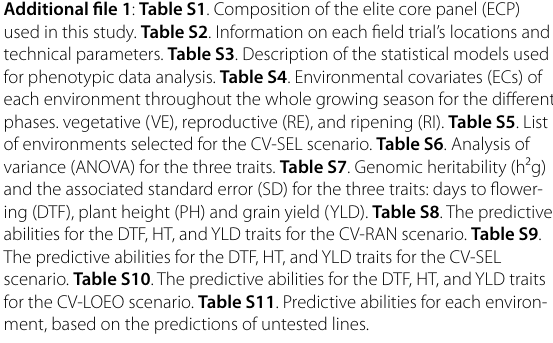
technical parameters. Table S3 . Description of the statistical models used for phenotypic data analysis. Table S4 . Environmental covariates (ECs) of each environment throughout the whole growing season for the different phases. vegetative (VE), reproductive (RE), and ripening (RI). Table S5 . List of environments selected for the CV‑SEL scenario. Table S6 . Analysis of variance (ANOVA) for the three traits. Table S7 . Genomic heritability (h²g) and the associated standard error (SD) for the three traits: days to flower‑ ing (DTF), plant height (PH) and grain yield (YLD). Table S8 . The predictive abilities for the DTF, HT, and YLD traits for the CV‑RAN scenario. Table S9 . The predictive abilities for the DTF, HT, and YLD traits for the CV‑SEL scenario. Table S10 . The predictive abilities for the DTF, HT, and YLD traits for the CV‑LOEO scenario. Table S11 . Predictive abilities for each environ‑ ment, based on the predictions of untested